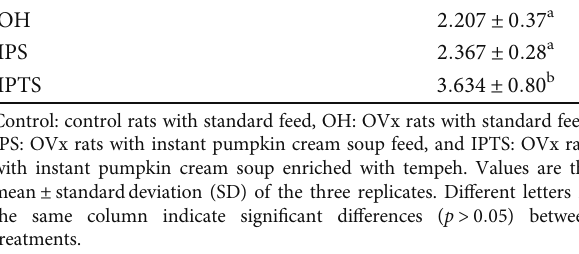
Table 2: Estradiol serum content on the blood of experimental rats. Groups